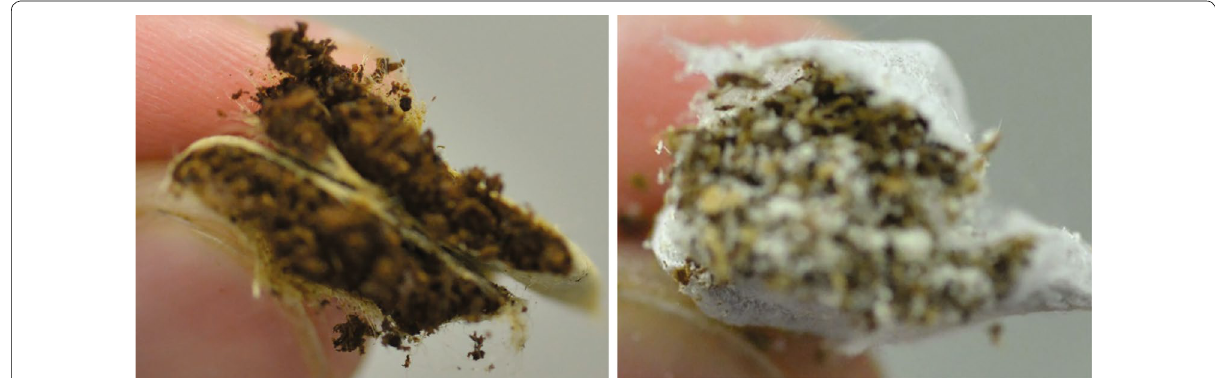
Fig. 1 Visual comparison of typical Swedish portion snus (left) and Oomph portion snus (right). Shown are cross-sections of the cut